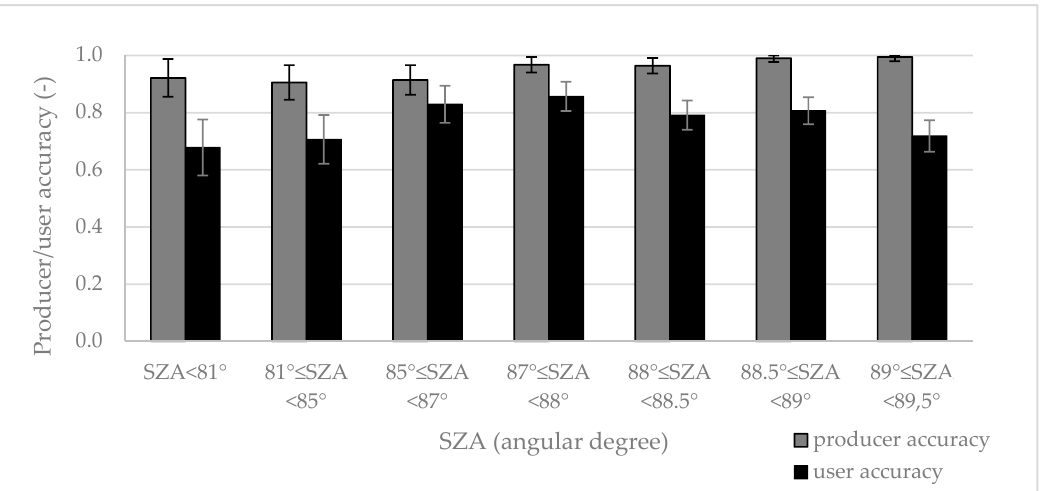
Figure 6. Evolution of the producer and user accuracy of the snow cover class with sun zenith angle and their confidence intervals at 95%.